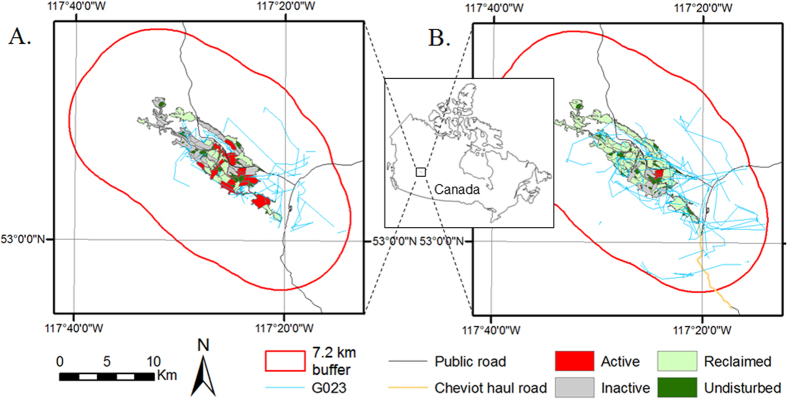
Mineral Disturbance Limits (MDLs) of two neighbouring open-pit coal mines (Luscar and Gregg River) in west-central Alberta, Canada where grizzly bear movement was investigated.MDLs comprise all color-coded polygons depicting mining activity status. A buffer with 7.2 km radius was delineated around MDLs to separate bear movements on and in the vicinity of MDLs from those far from the MDLs (control). The buffer radius represents a distance equal to the 95th percentile of the greatest step length of GPS collared grizzly bears which used the MDLs at least once in the monitoring period. Two insets are provided for the median years of grizzly bear data availability: during (A-2001) versus after (B-2009) mining to illustrate the dynamic nature of mining activity. Four-hour path segments of a female grizzly bear with cubs (G023) are provided for 2001 and 2009 as an example. The map was generated in ArcGIS 10.1 (ESRI, Redlands, USA).